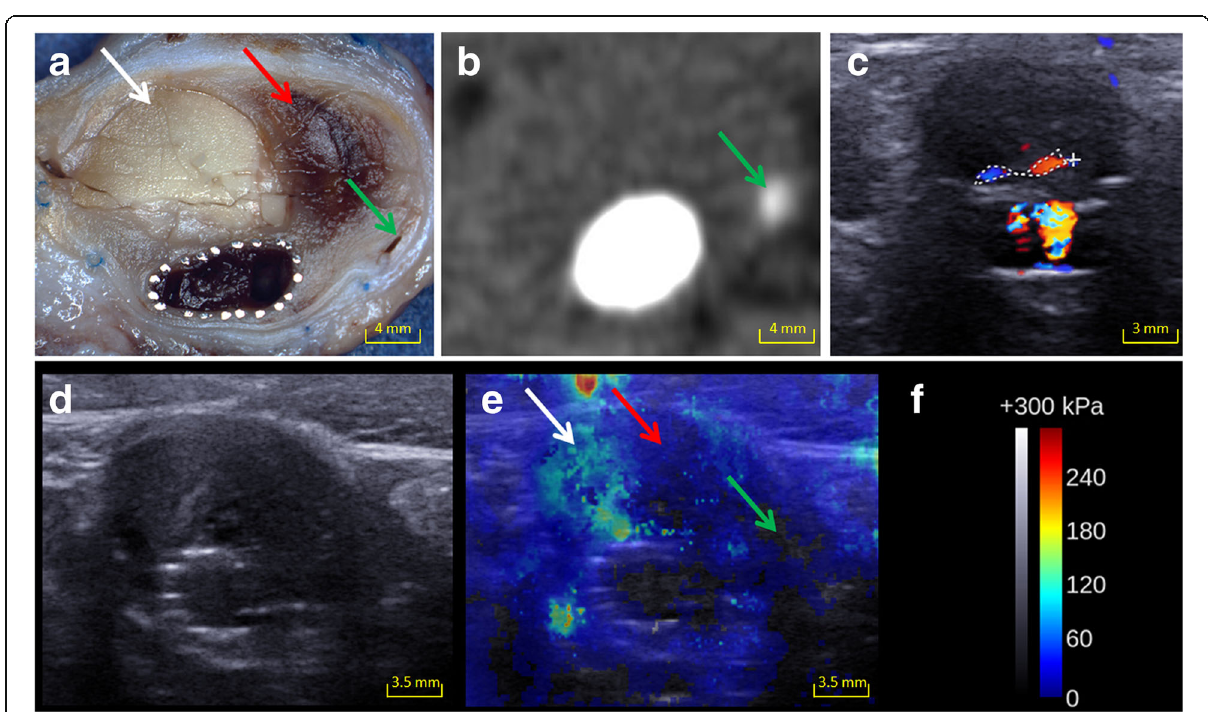
Fig. 2 Images from an aneurysm with endoleak ( green arrow ), chitosan ( white arrow ) and massive fresh thrombus ( red arrow ). a Macroscopic cut showing the different regions of interest. b The small endoleak is depicted on CT scan. c DUS showing the endoleak. d On B-mode ultrasound, the chitosan is seen as a hyperechoic area but endoleak area is not clearly depicted. e The regions of interest corresponding to chitosan, soft thrombus and endoleak are depicted on SWI. f Colour scale and Q-Box values for SWI